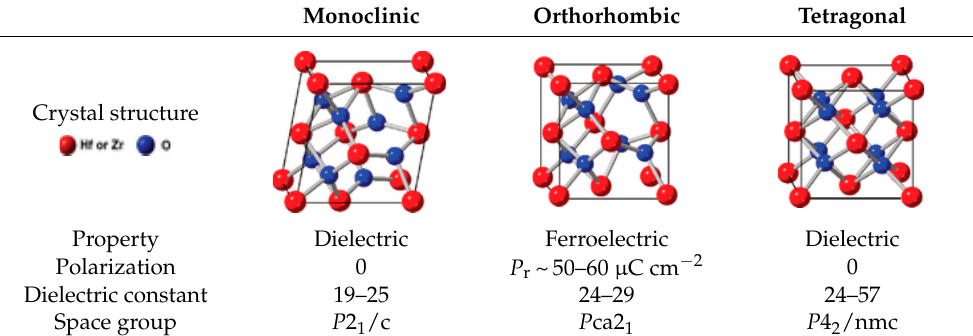
Table 2. Key characteristics according to representative polymorphs of fluorite-structured HfO 2 and ZrO 2 . [73].